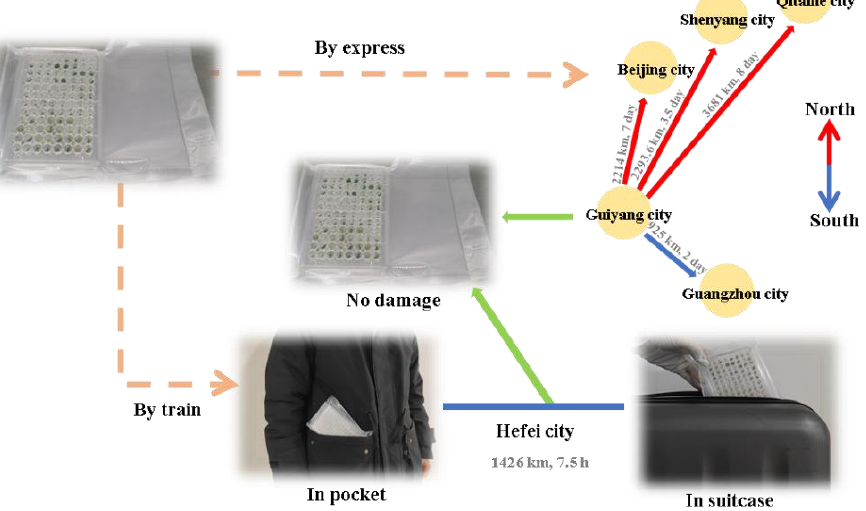
Figure 8. The transportation and shipping feasibility of micro-cuttings encapsulated in vacuum- packed microplates.